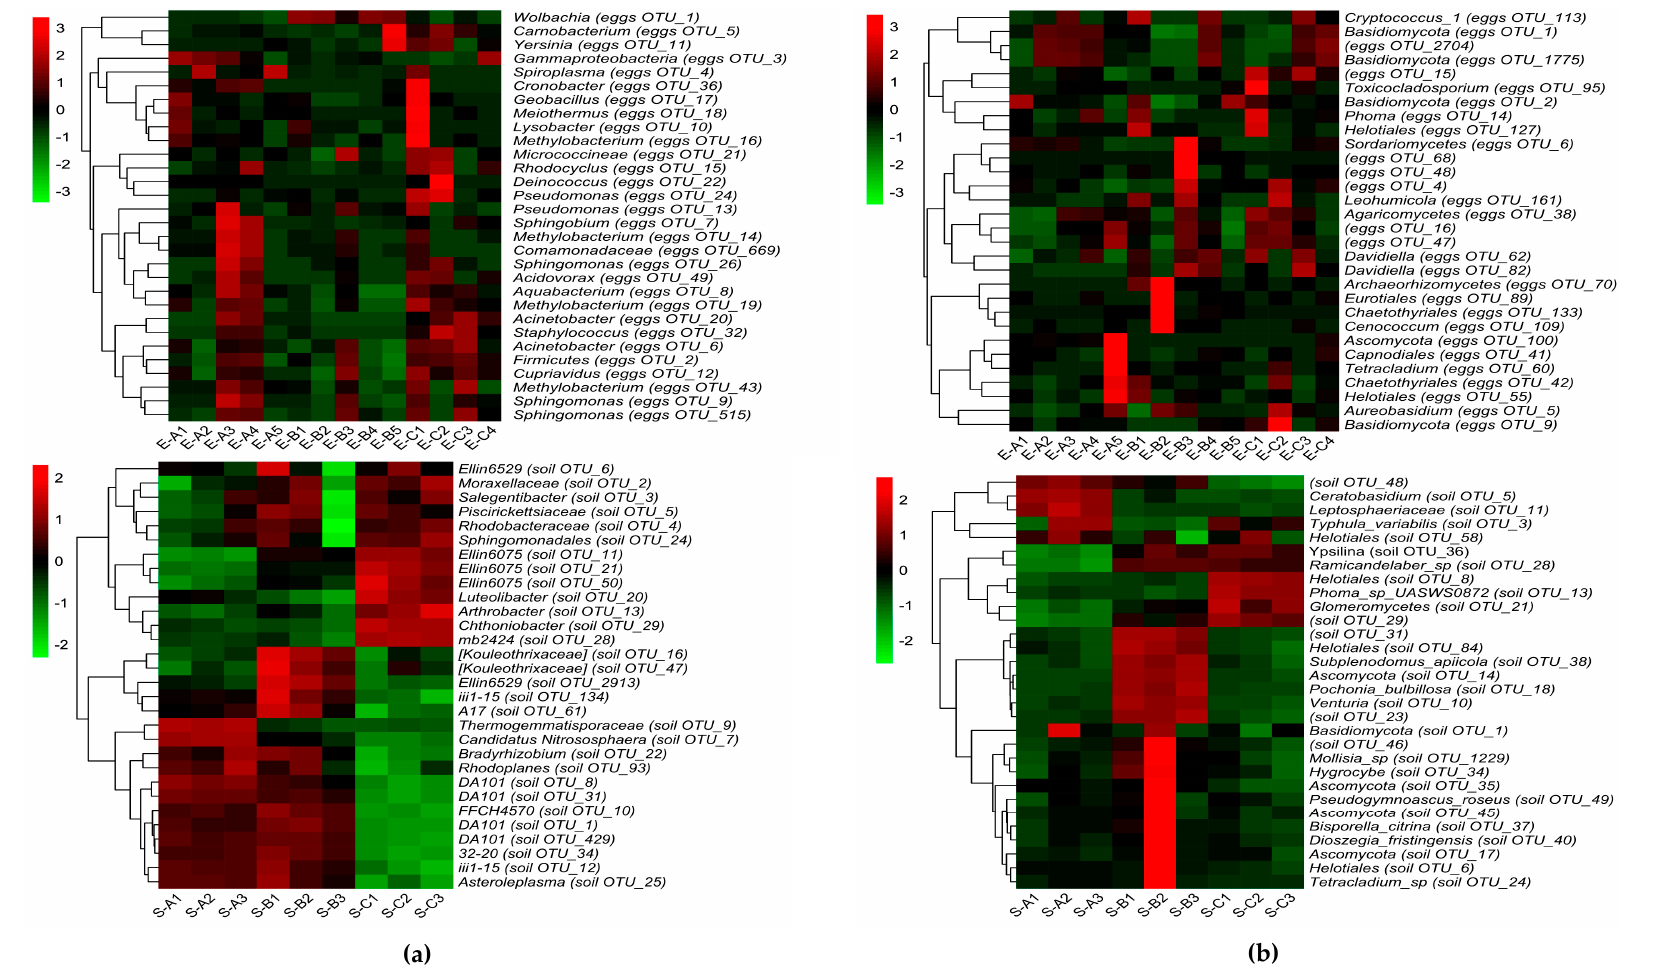
Figure 5. Heatmaps of the top 30 OTUs of bacterial ( a ) and fungal ( b ) communities of unfertilized eggs (E) and soil (S) samples at each site. Relative abundance of the microbial community from high to low is represented by red, black, and green. A, B, and C present different sampling sites with high, low, and null Chinese cordyceps, respectively.